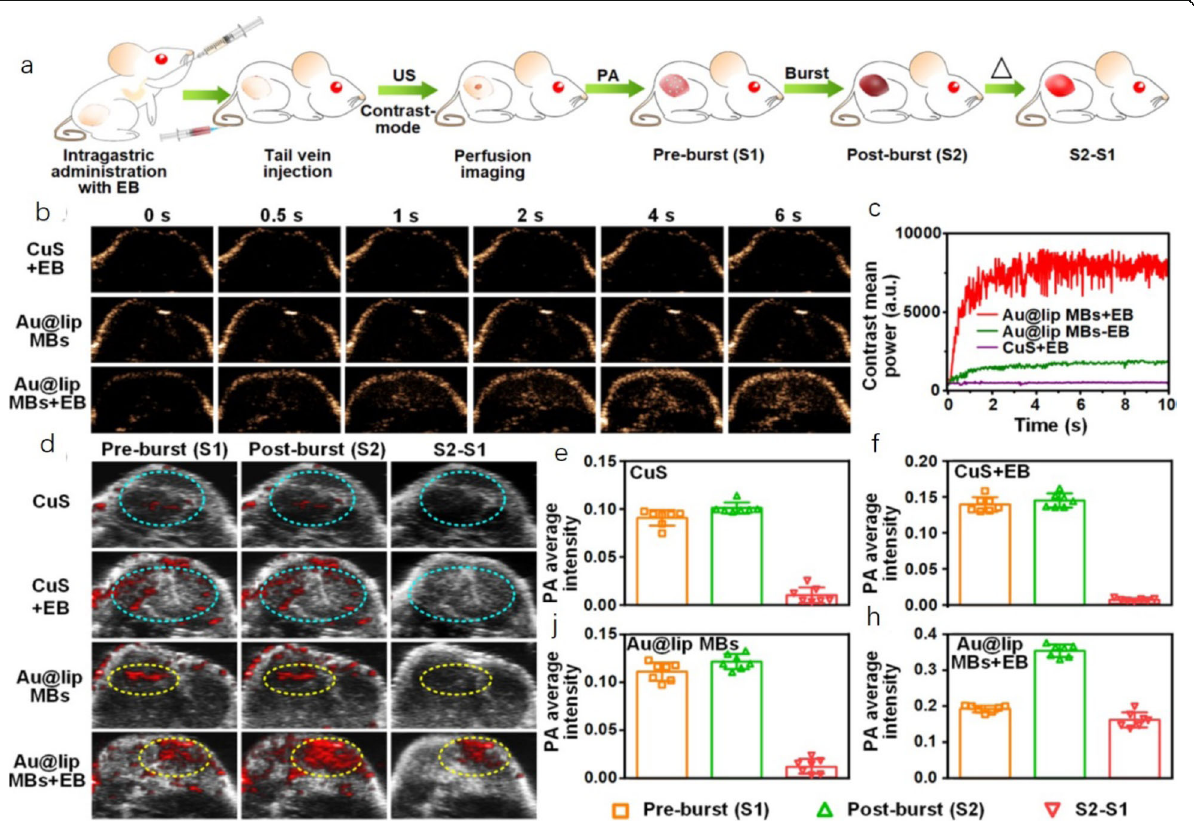
Fig. 10 Background-free PAI to study tumor blood perfusion with Au@lip MBs